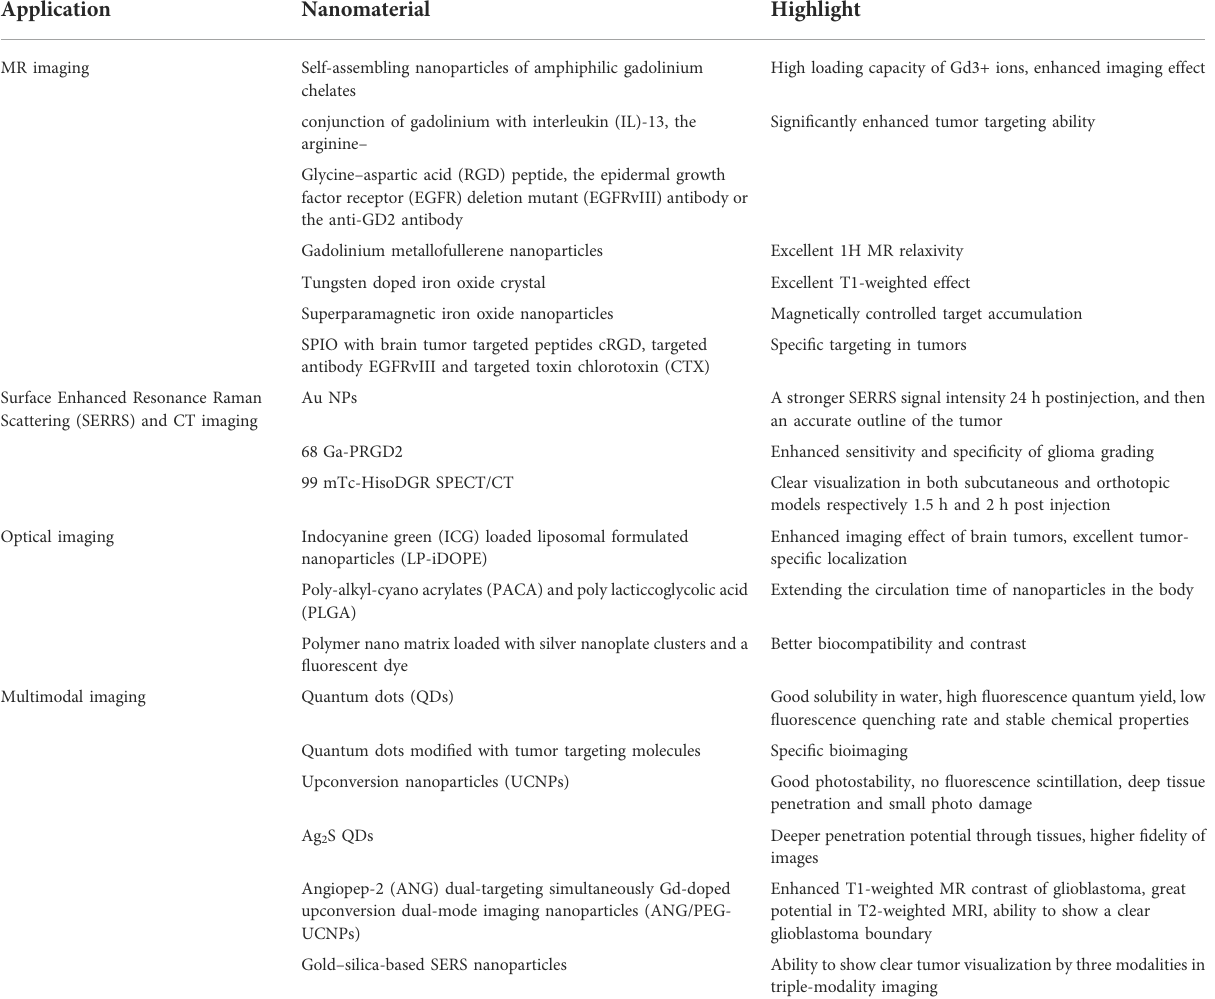
TABLE 1 Nanomaterialbased diagnostic for